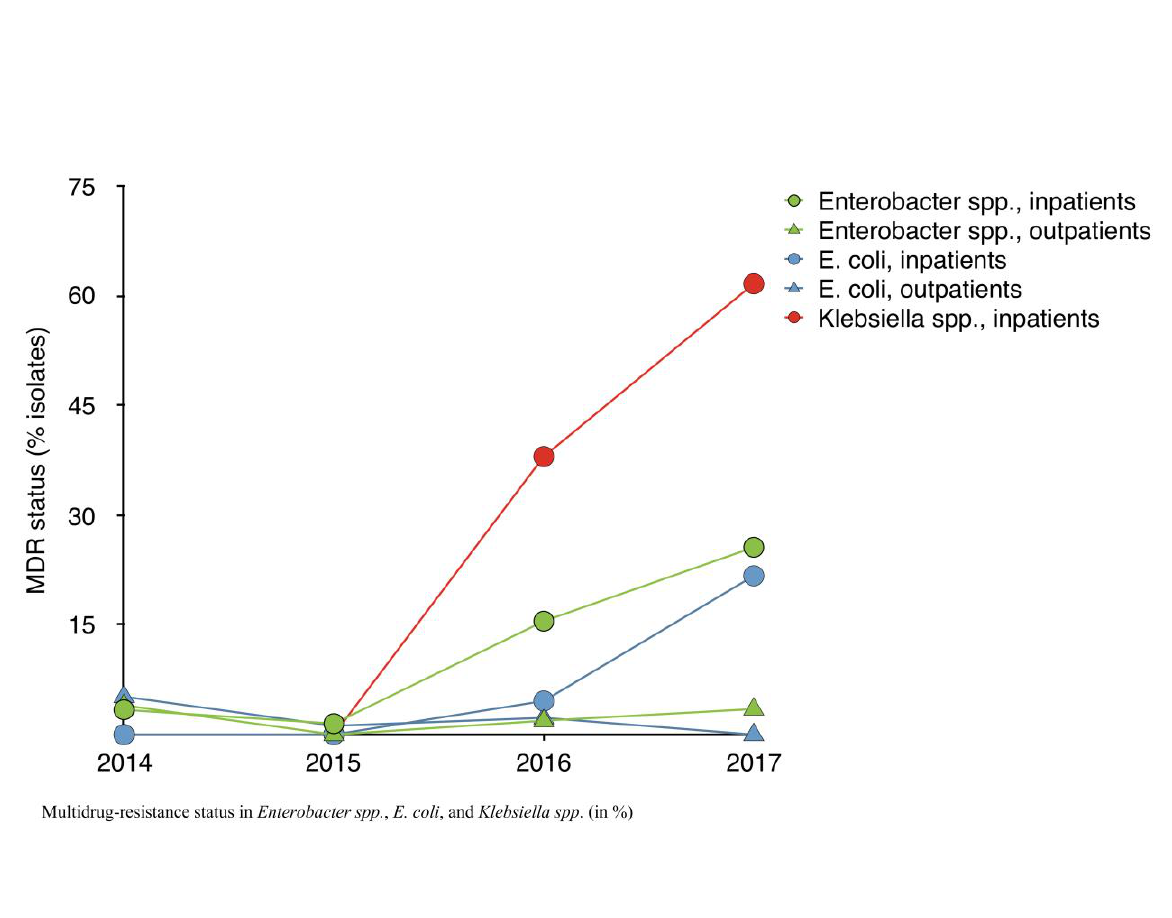
Figure 4. Multidrug-resistance status in Enterobacter spp., E. coli, and Klebsiella spp. (in